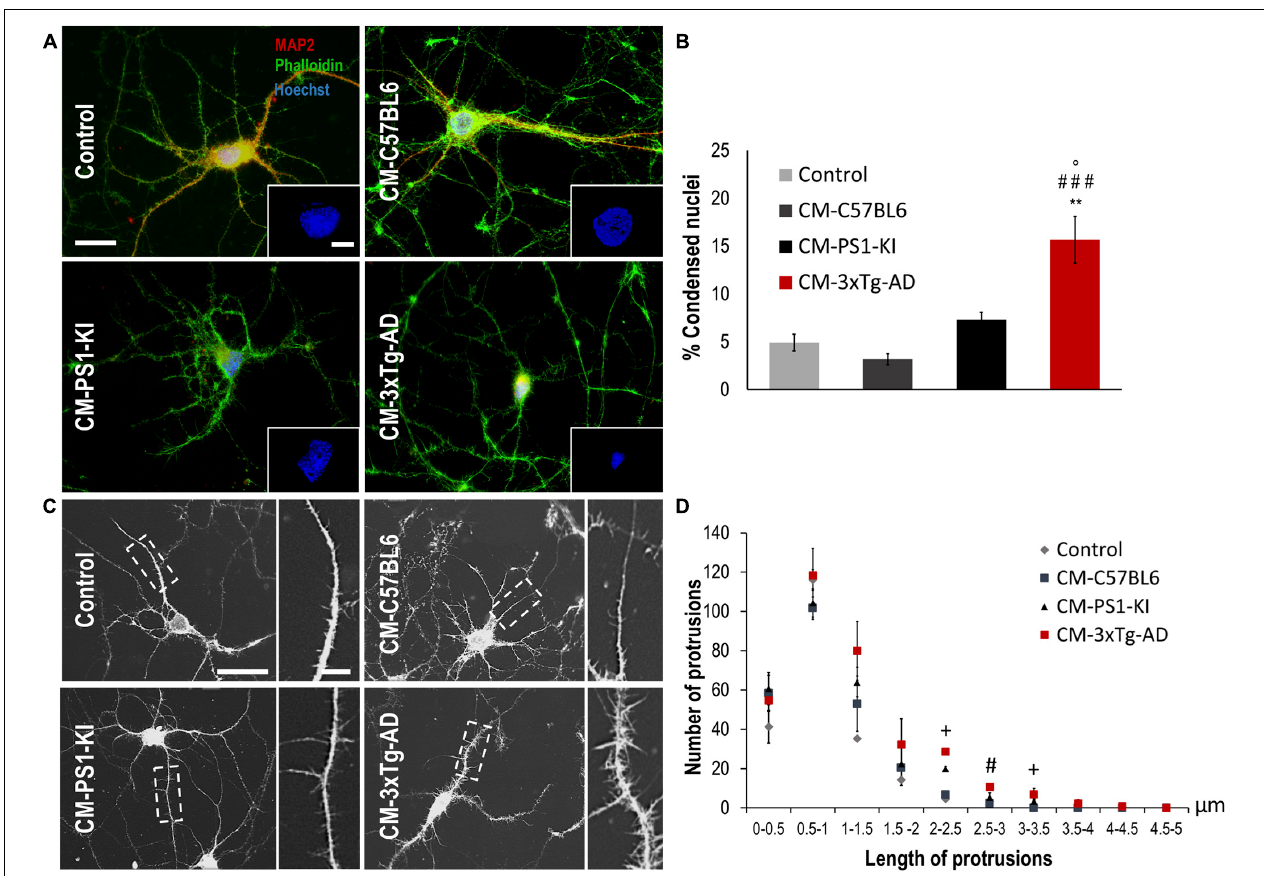
FIGURE 2 | CM from adult 3xTg-AD astrocytes decreased viability and generated filopodia-like dendritic protrusions in neurons in vitro . (A) Immunofluorescence of neurons treated with CM from control or 3xTg-AD astrocytes. Hoechst nuclear staining is blue. Phalloidin-Alexa 488 staining of F-actin is green. MAP2-Alexa 594 staining of microtubule-associated protein 2 is red. Calibration bar: 20 µ m. Details of condensed nuclei at 50% zoom, calibration bar: 5 µ m. (B) Quantification of the average percentage of condensed nuclei. Average number of condensed nuclei was compared in various treatments. n = 3; ANOVA comparisons of 3xTg-AD with *Control; #CM-C57BL6; ◦ CM-PS1-KI. P-value significance: ### 0.001; **0.01; ◦ 0.05. (C) Neurons exposed to CM of astrocytes during 24 h; calibration bar: 20 µ m. Details in the dotted rectangle show 100% magnification of the dendrites with the spines; calibration bar: 5 µ m. (D) Distribution of the number of spines according to the length range. n = 3; ANOVA comparisons of 3xTg-AD with #CM-C57BL6. P -value significance: #0.05. Kruskal-Wallis analysis of non-normally distributed data. P -value significance: